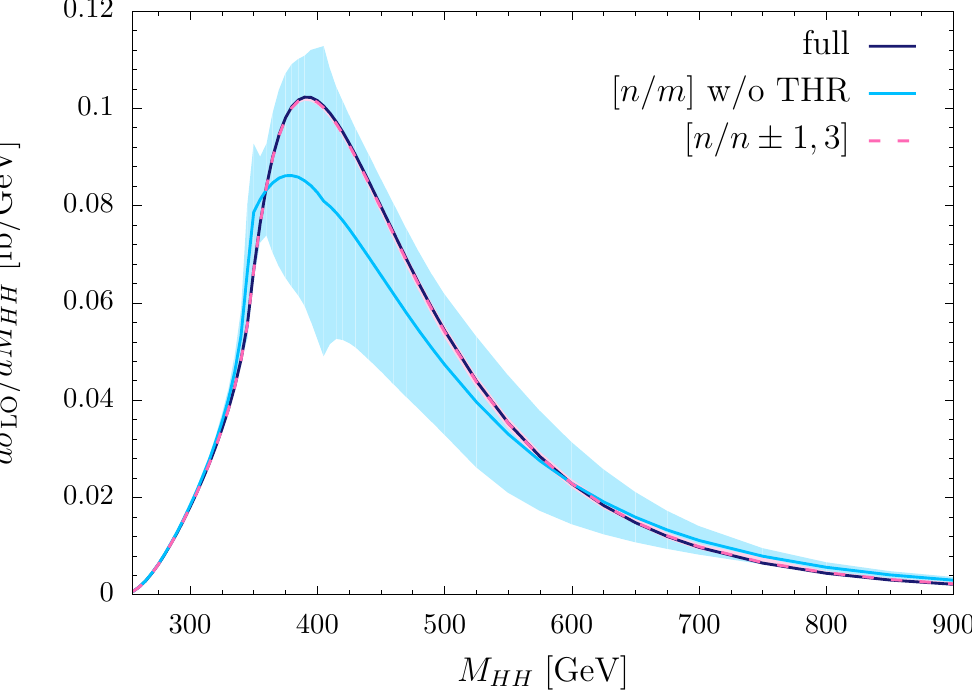
Figure 9 . Invariant Higgs mass distribution for the full LO cross section (dark blue), the [ n=n (cid:6) 1 ; 3] Pad(cid:19)e approximants (pink line) and the Pad(cid:19)e constructed without threshold expansion (light blue). The standard deviation of the Pad(cid:19)e lines are shown by the semi-transparent regions with the corresponding color. The pink band is barely wider than the width of the curves and hardly